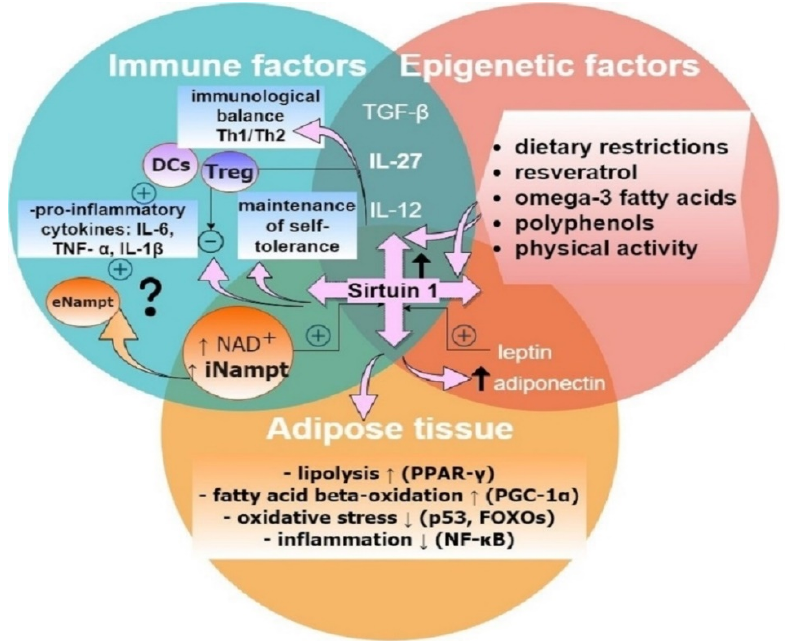
Figure 1. Sirtuin 1 is a possible link between metabolic and immunological pathways. The expres- sion of sirtuin 1 depends on epigenetic factors and influences adipose tissue metabolism through various transcription factors to reduce lipogenesis [15] and oxidative stress [16], and it also has anti-inflammatory effects [17] and regulates the secretion of adipokines [18]. Visfatin intracellularly (iNampt) catalyzes the reaction of the NAD+ synthesis pathway, which increases sirtuin 1 activity [19], while extracellularly (eNampt) it regulates responses to oxidative stress and inflam- mation [20]. Sirtuin 1 influences the immune system through cytokines, maintaining the balance between Th1/Th2/Th17/Treg lymphocytes’ defense against autoimmunity [21]. IL-27, together